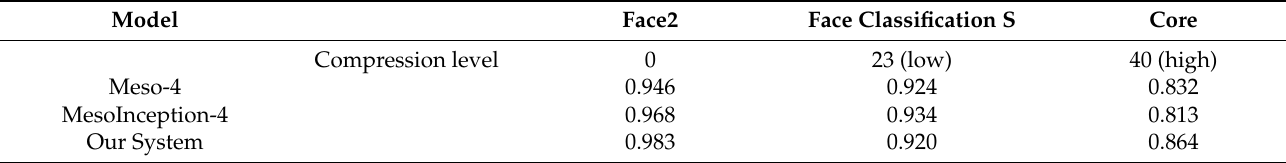
Table 5. Face2face classification scores